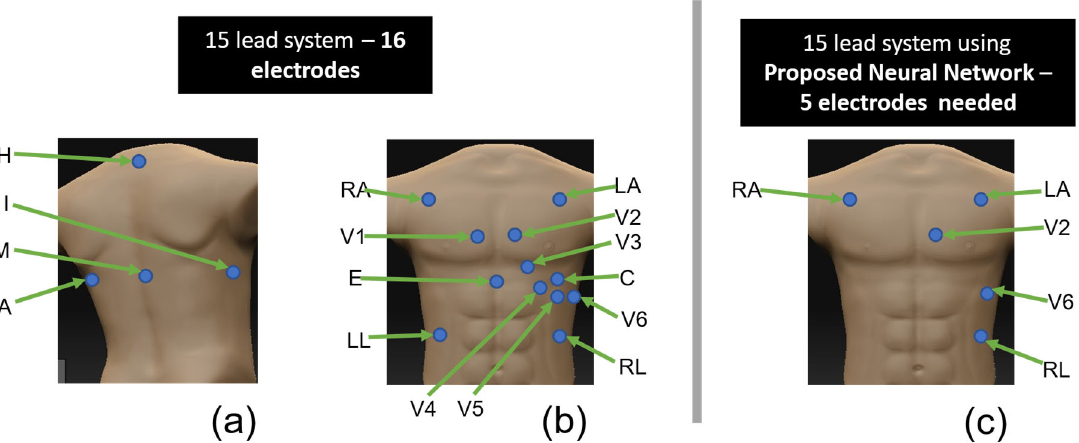
Figure 1. Comparison of electrode placement needed for a 15-lead system and the proposed method. For 15-lead system ( a ) electrode placements on the ventral side ( b ) electrode placements on the dorsal side. For the proposed method ( c ) electrode placements only on the ventral side [7,23] .